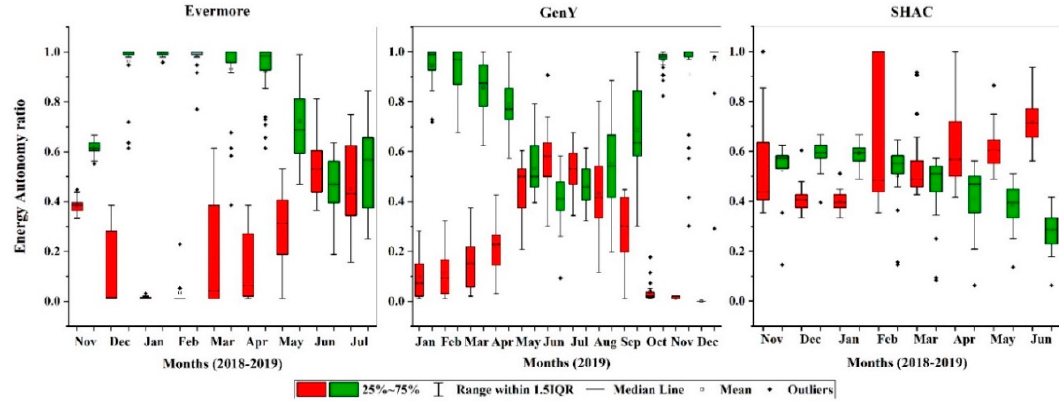
Figure 10. Energy autonomy ratio for configurations at three sites.